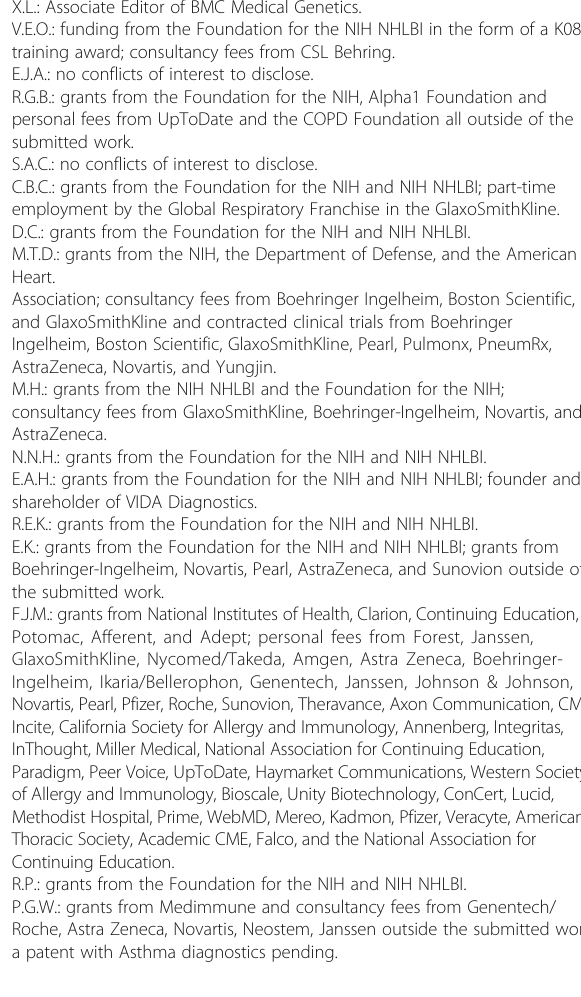
Additional file 1: Table S1. Association Results of the Top SNPs ( P <10 − 4 ) with Post-bronchodilator FEV 1 /FVC. Table S2. Association Results of the Top SNPs ( P <10 − 4 ) with Post-bronchodilator % Predicted FEV 1 . Table S3. Genotype Frequency of rs28929474 in SERPINA1 Stratified by GOLD Stages. Table S4. Prediction Models for Post-bronchodilator Lung Function Using Top 10 SNPs for Post-bronchodilator % Predicted FEV 1 . Figure S1. Joint analysis of the top10 SNPs for post-bronchodilator % predicted FEV 1 in 1075 SPIROMICS non-Hispanic White smokers with COPD. (DOCX 141 kb)